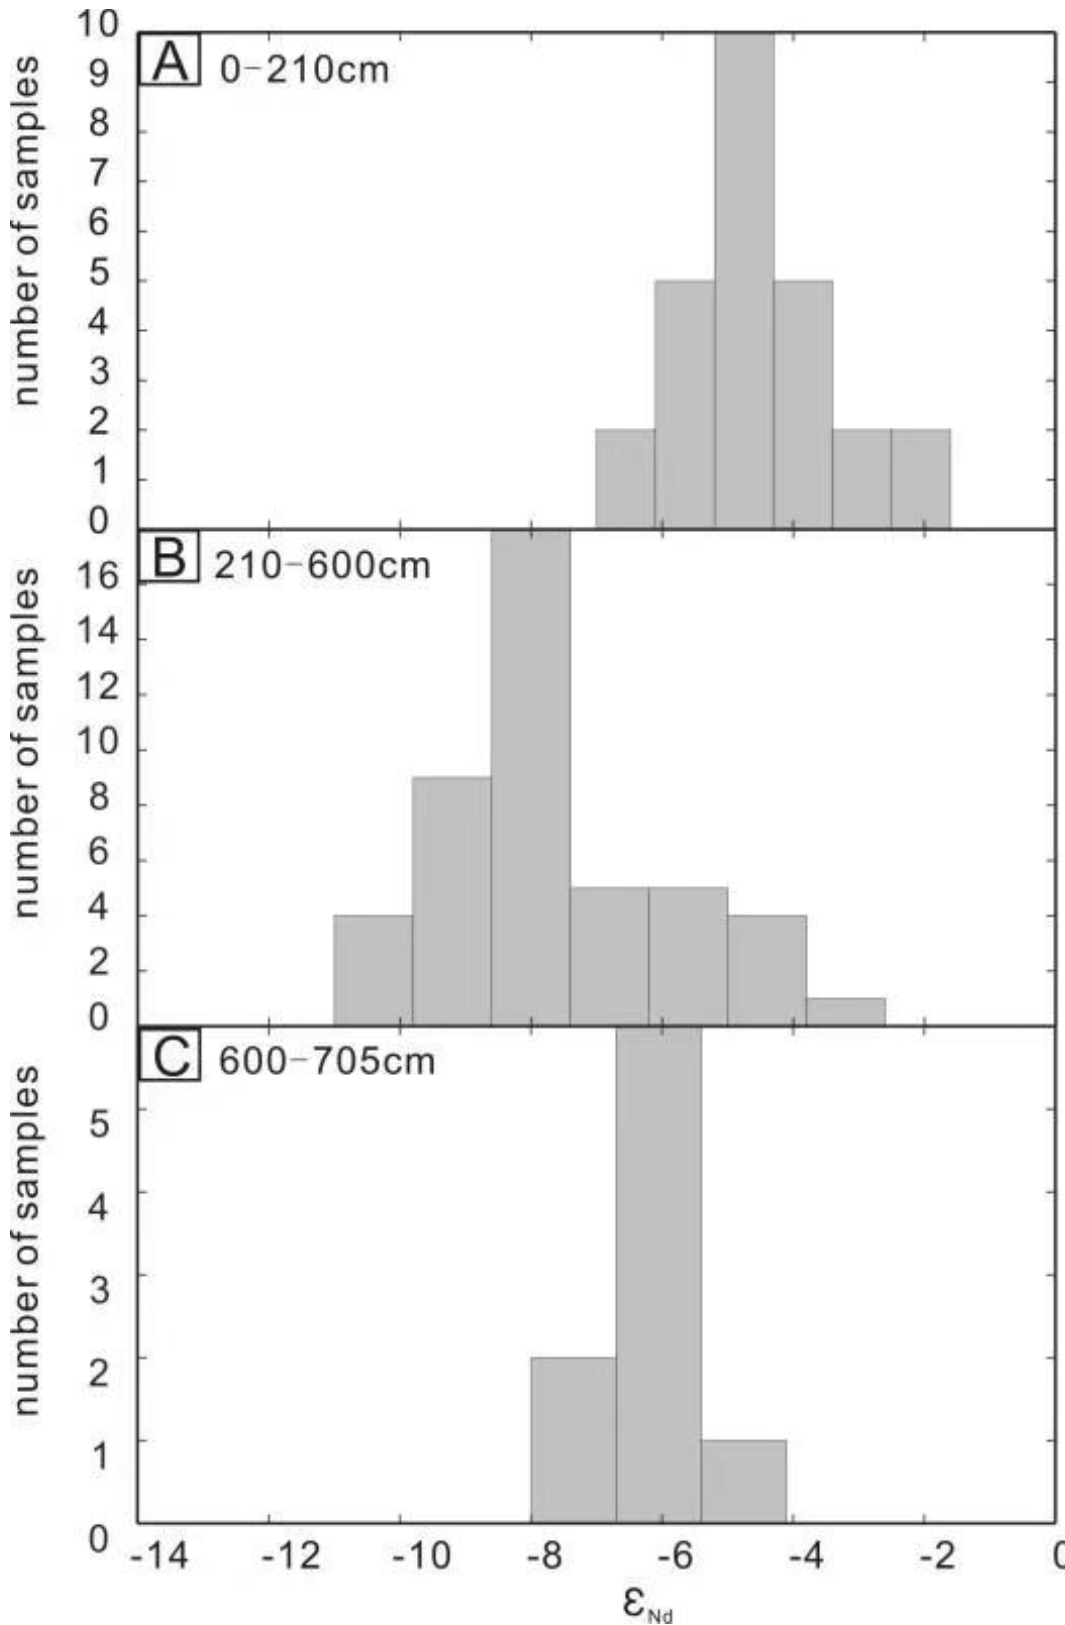
Figure 7. In situ fish teeth ε Nd values in core P10. ( A – C ), the 0–210 cm layer, the 210–600 cm layer and 600–705 cm layer of